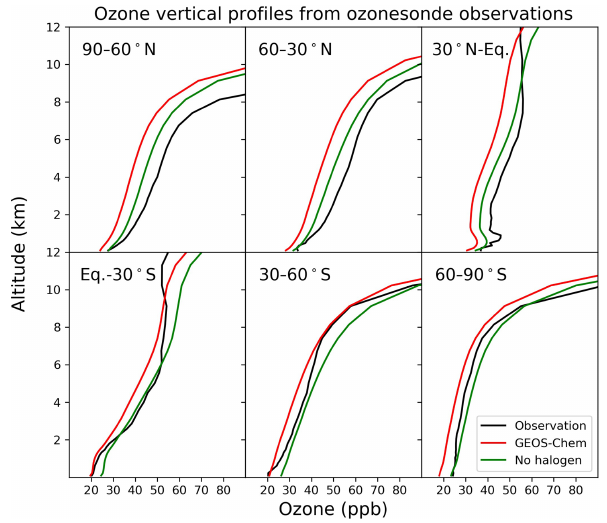
Figure 15. Annual average vertical profile of ozone mixing ratios from ozonesonde observations and the model for six zonal